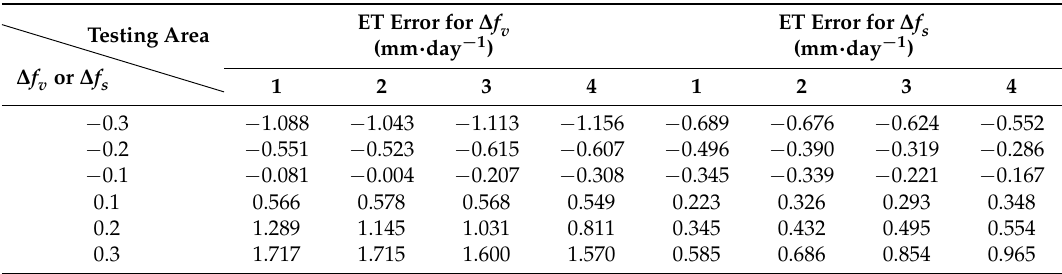
Figure 14. Sensitivity of ET with the variation of vegetation fraction ( a ) and soil fraction ( b ). Table 8. ET error between the initial ET and the corresponding ET with the variation of f v (or f s Testing Area